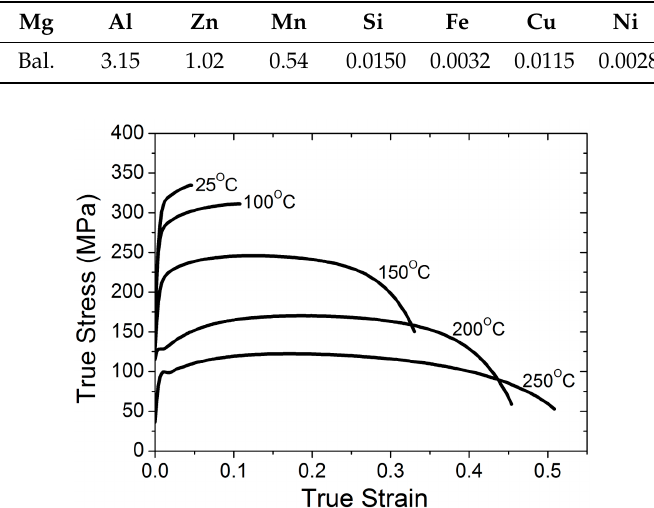
Figure 3. ( a ) Main components of the blanking device (sectional view); ( b ) magnified illustration of the selected blanking parameters.